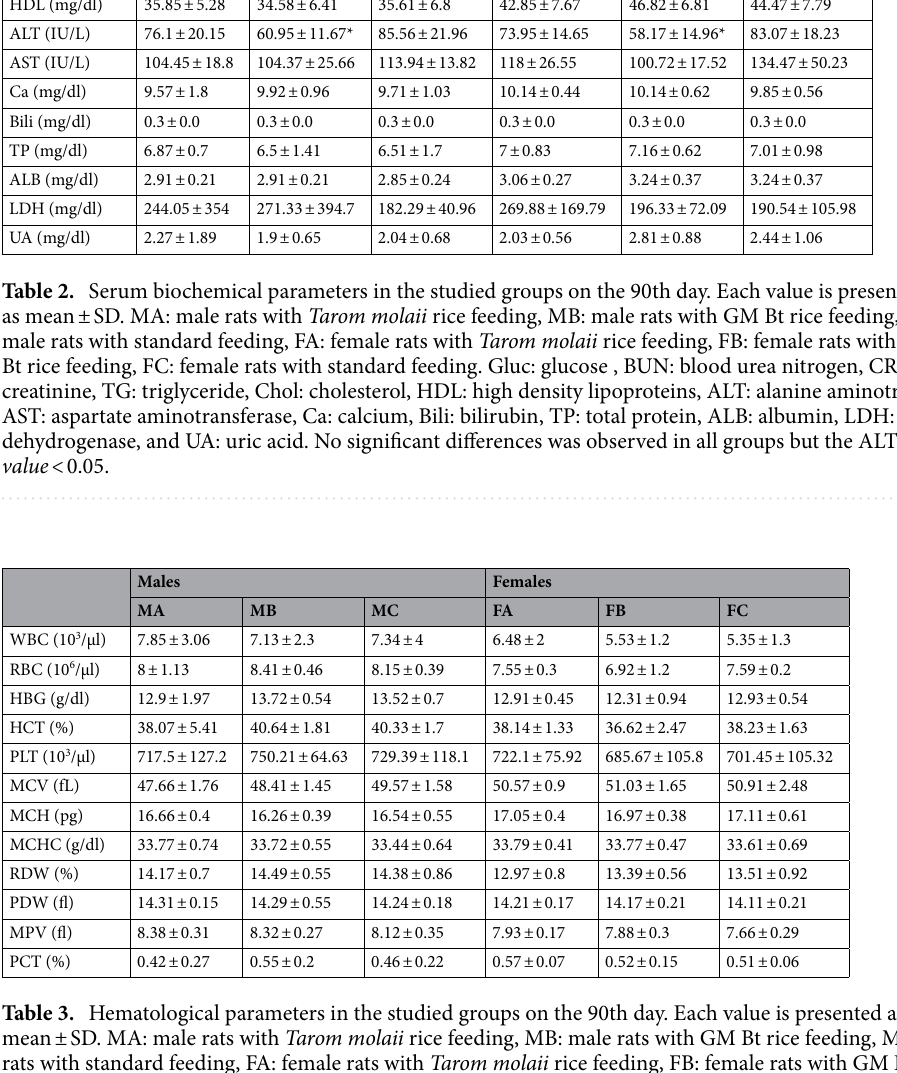
The results of hematological parameters in all studied groups showed no statistically signifi- cant differences ( p > 0.05; Table 3).